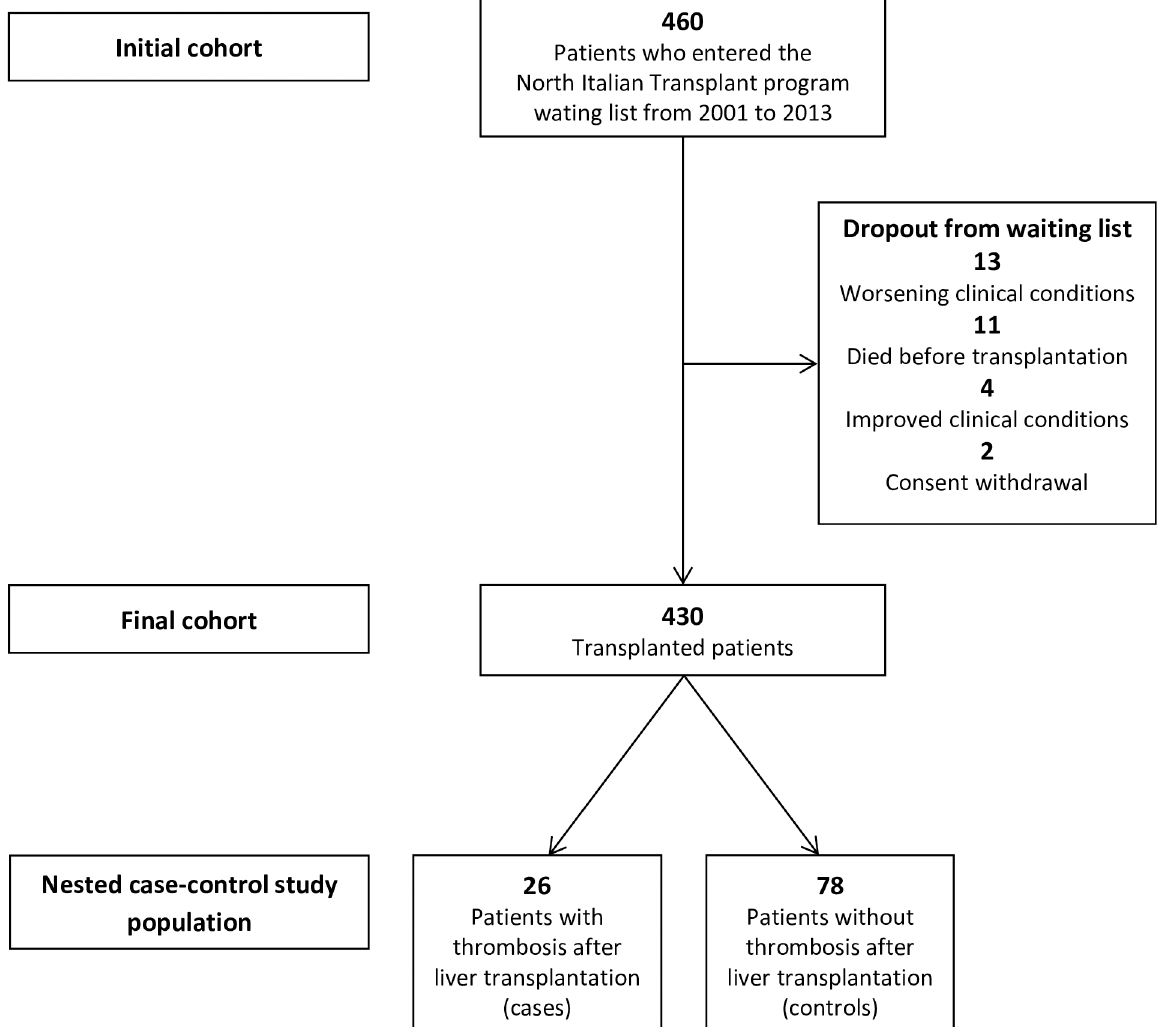
Fig 1. Flow-chart of the study population of patients with hepatocellular carcinoma.